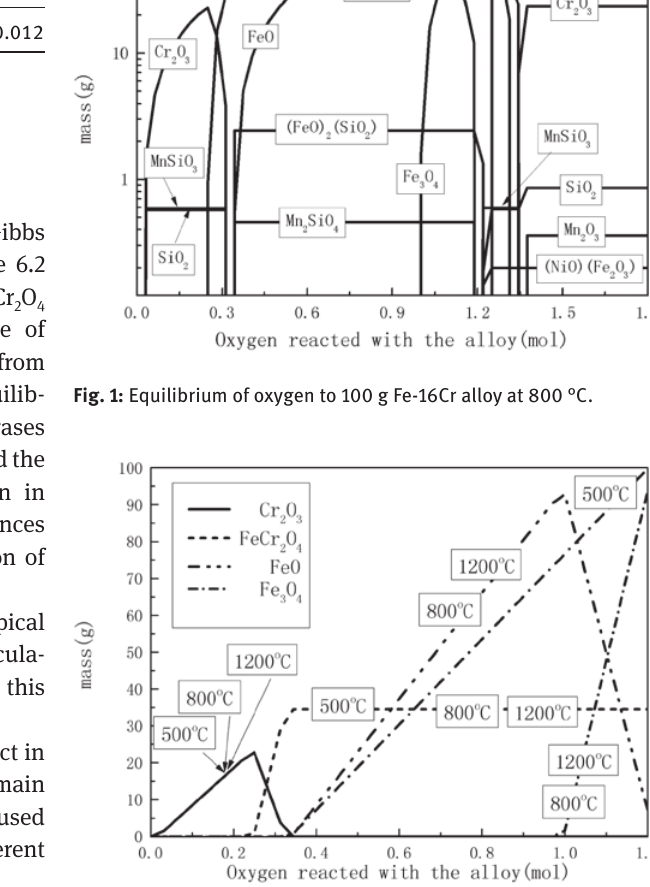
Fig. 2: Equilibrium of oxygen to 100 g Fe-16Cr alloy at different